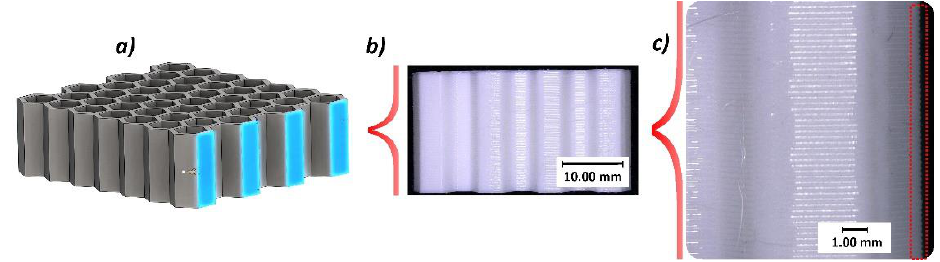
Figure 7. The view of the side surface of 3D printed honeycomb specimen: ( a ) 3D CAD model, ( b ) general view of specimen, ( c ) view with magnitude ×20.